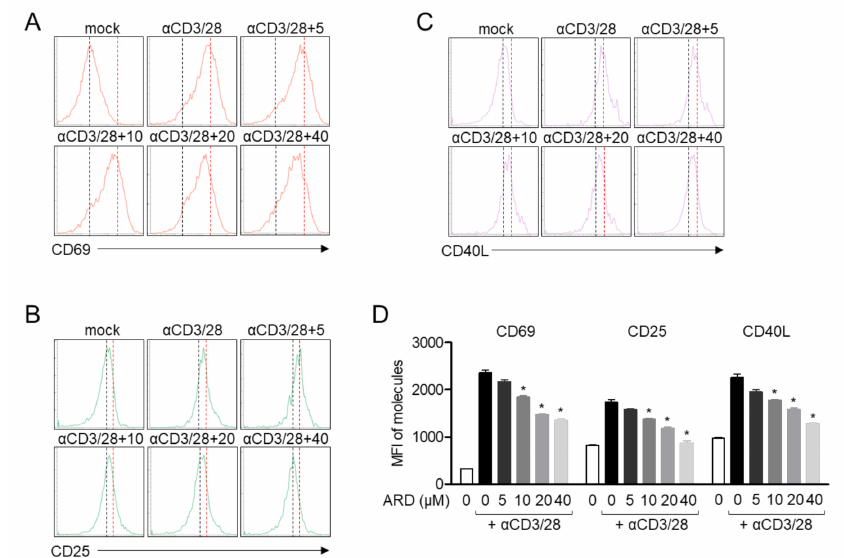
Figure 4. Aromadendrin reduces the expression of surface molecules in activated T cells. Jurkat T cells, pre-treated with 40 µ M of aromadendrin for 1 h, were stimulated with anti-CD3 / CD28 antibodies for 16 h ( A ) or 24 h ( B , C ). Collected cells were stained with anti-CD69, anti-CD40L, and anti-CD25 antibodies conjugated with APC (allophycocyanin) and the expression was analyzed by flow cytometry. ( D ) The mean value ± SEM of CD69, CD25 and CD40L are presented in the bar graph. * p < 0.05, versus the cells activated by anti-CD3 / CD28